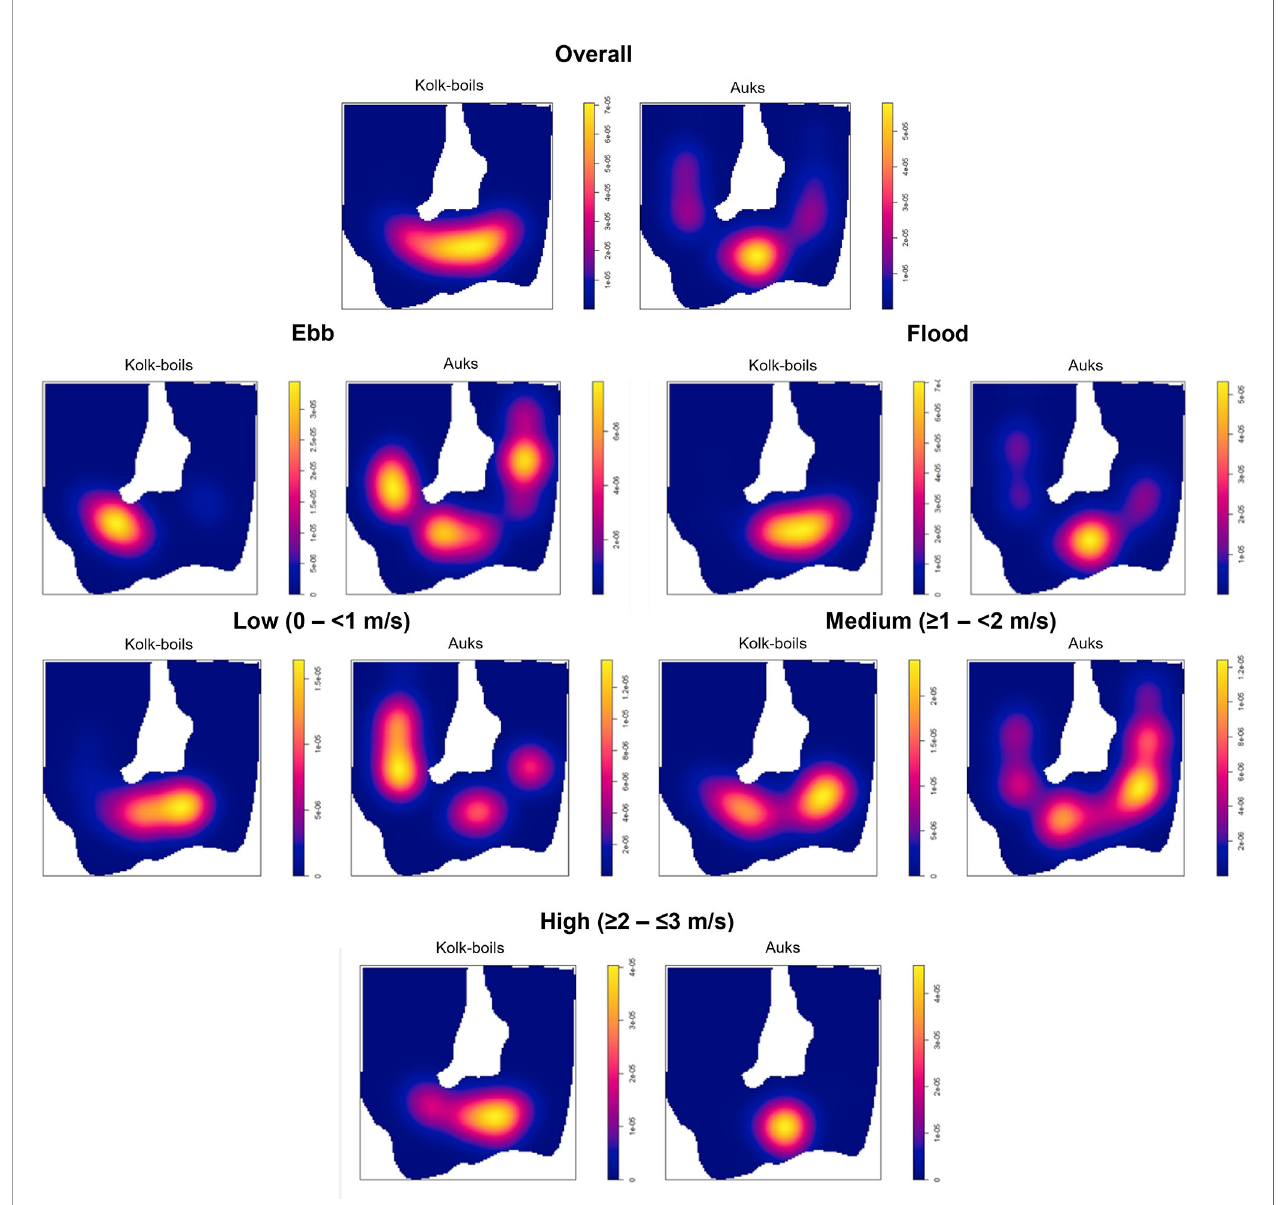
FIGURE 4 | Density distributions (individuals/m²) of kolk-boils and auks overall, across ebb and fl ood tidal phases and at differing current velocity ranges (at 200 m bandwidth) across the Inner Sound and island of Stroma areas of the Pentland